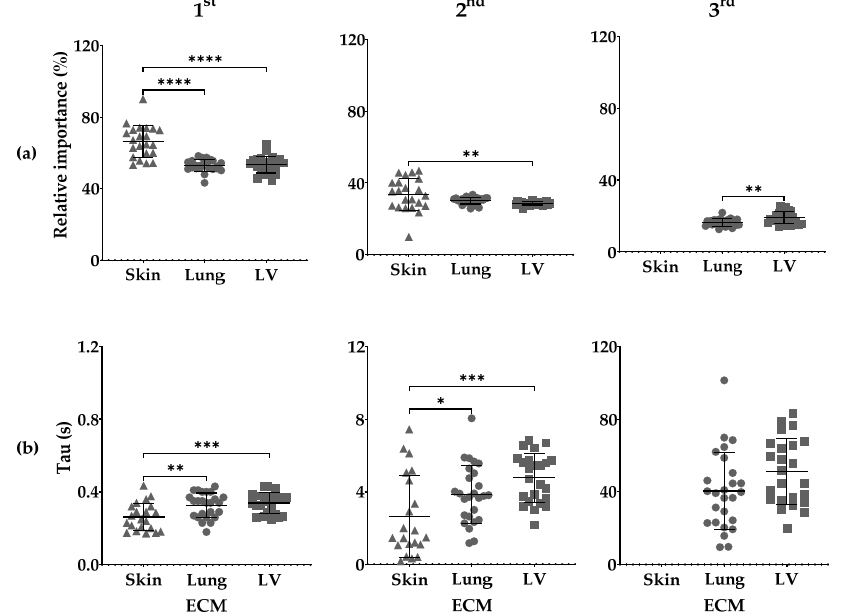
Figure 4. Maxwell analysis of skin-ECM, lung-ECM and LV-ECM viscoelasticity. ( a ) Relative importance of 1st, 2nd and 3rd Maxwell elements; ( b ) Tau ( τ ) of 1st, 2nd and 3rd Maxwell elements reported in seconds (s). All data derived from a minimum of three independent experiments performed in triplicates. Data are presented as mean with SD. Statistical differences according to one-way ANOVA and Tukey (1st and 2nd Maxwell Elements) and Student’s t -test (3rd Maxwell Element) * p <